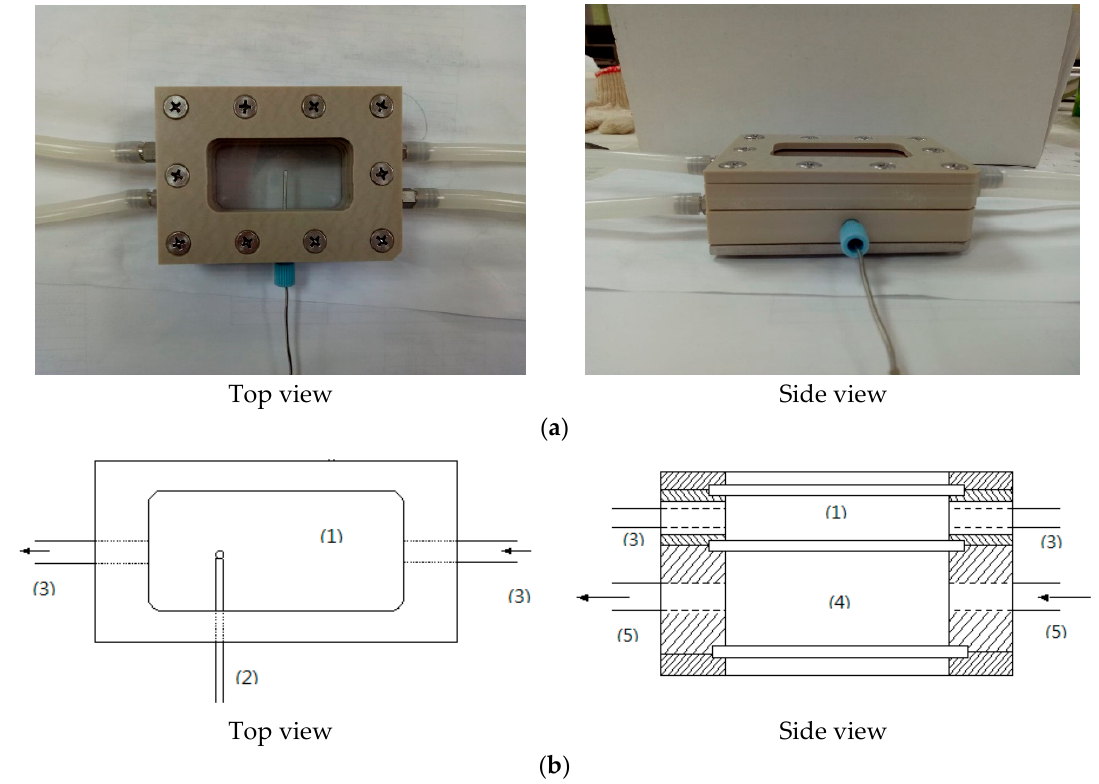
Figure 2. The photomicroscopic growth apparatus ( a ) the real picture of growth cell; ( b ) schematic diagram of growth cell with the features: (1) solution chamber; (2) thermistor; (3) solution inlet and outlet; (4) constant-temperature water chamber; (5) water inlet and outlet.